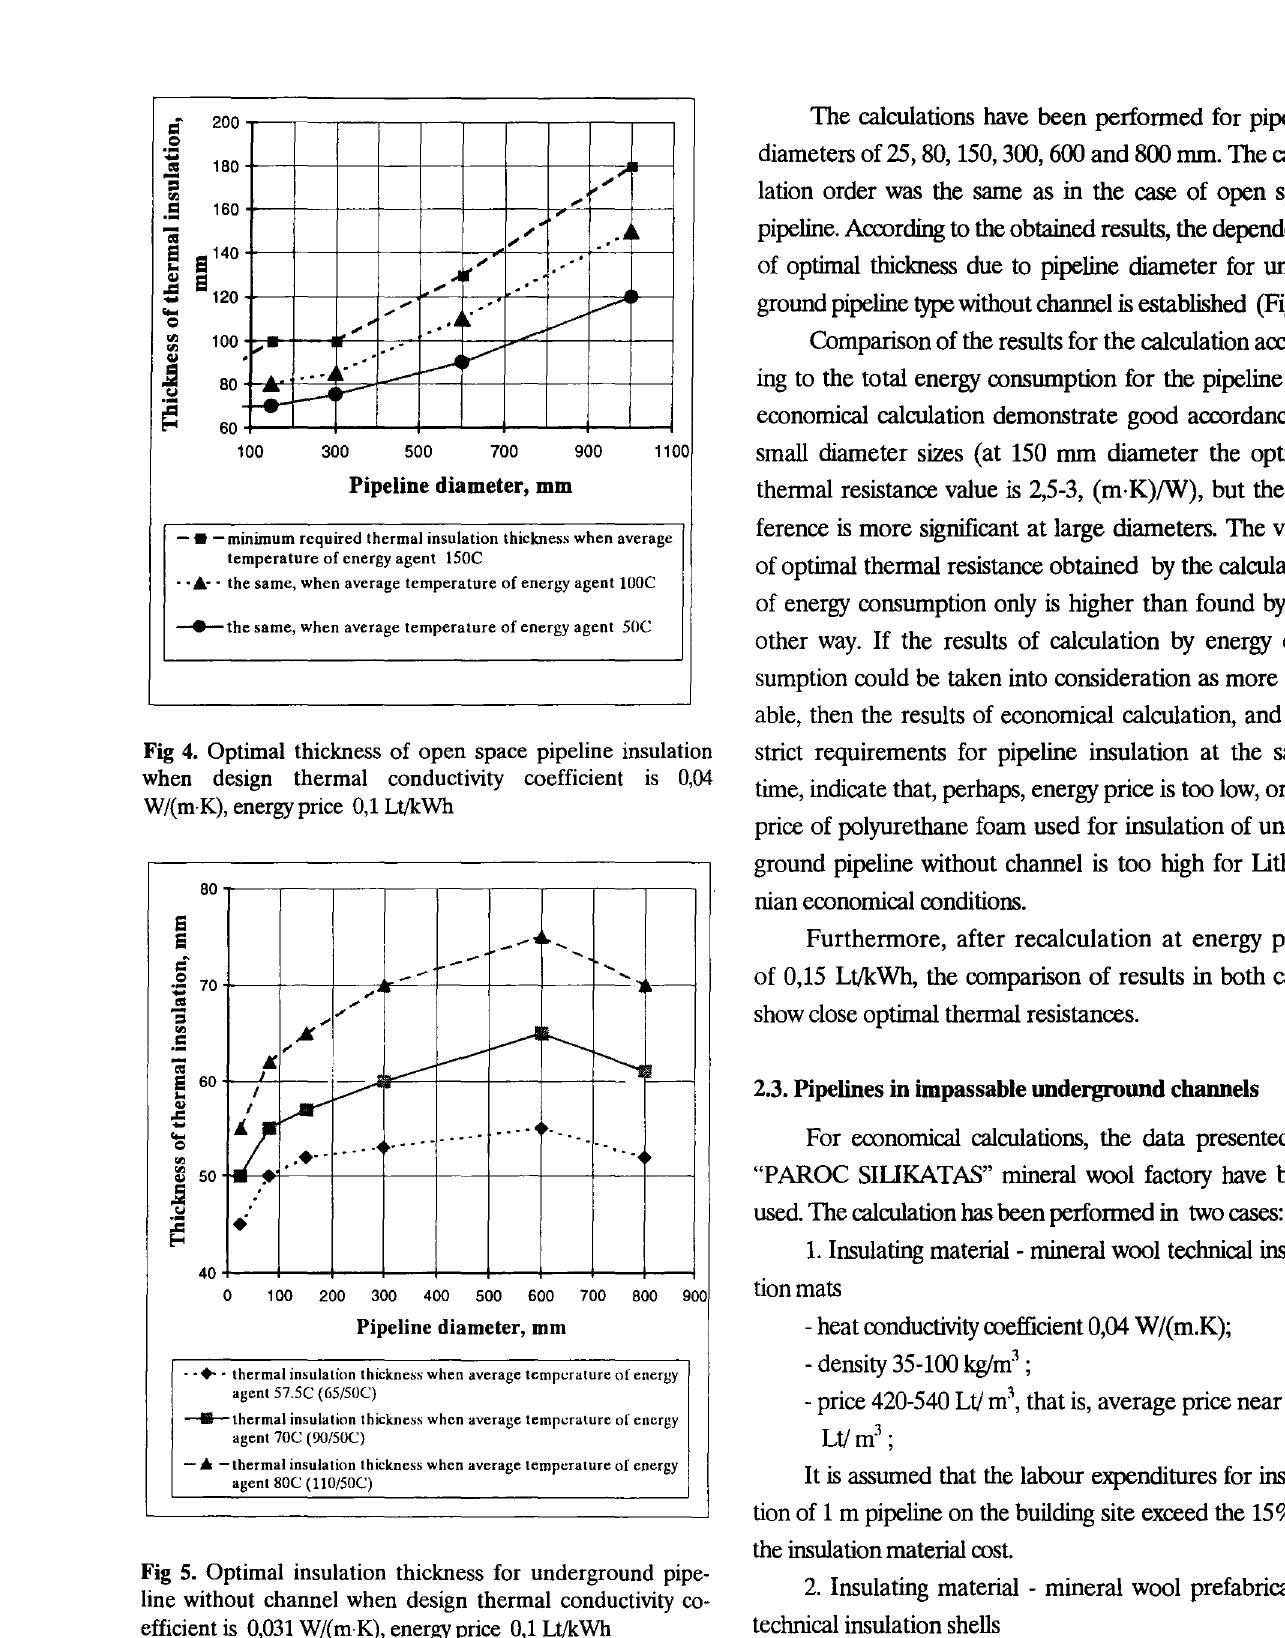
It is assumed that the labour expenditures for insula tion of 1 m pipeline on the building site exceed the 10% of the insulation material